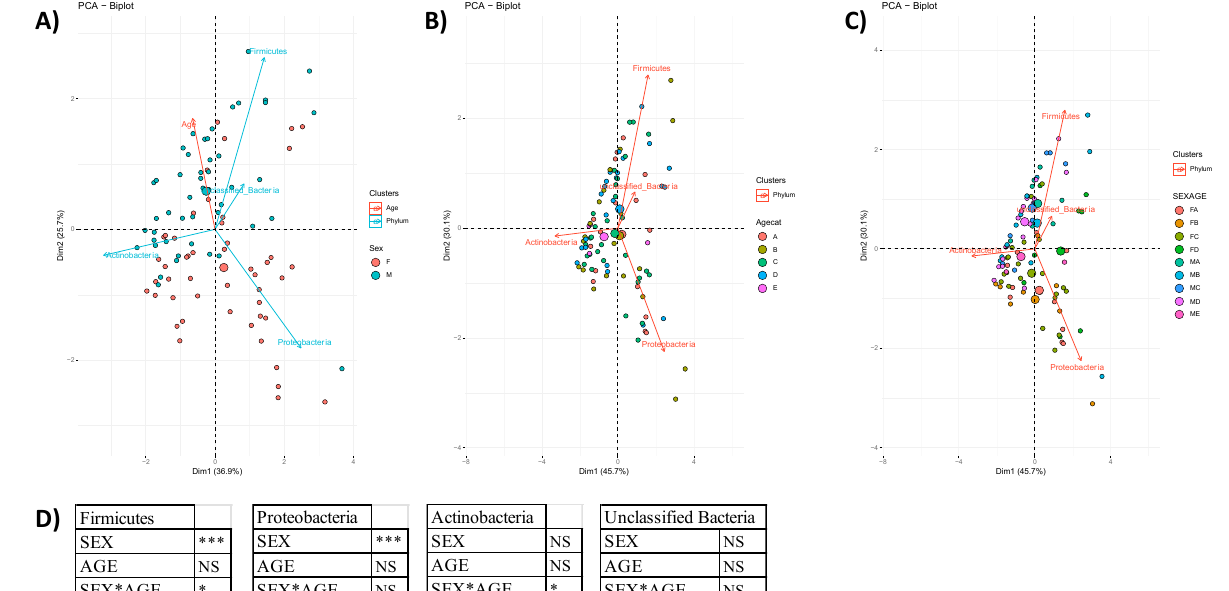
Figure 1. PCA analysis at Phylum level based on the following: ( A ) Sex (62.6% of variability explained by dimensions 1 and 2); ( B ) Age categories (A: 25–35 years old, B: 36–45, C: 46–55, D: 56–65, E: 66–70; 75.8% of variability explained by dimensions 1 and 2); ( C ) Sex + Age categories, 75.8% of variability explained by dimensions 1 and 2). The largest ball represents the mean of the samples, while the small dot indicates the single sample. ( D ) Two-way ANOVA results for the phyla Firmicutes, Proteobacteria, Actinobacteria and Unclassified bacteria considering the two factors “Sex”, “Age” and their interaction “Sex*Age”. NS = Not Significant; * = Significant at p < 0.05; ** = Significant at p < 0.01; *** = Significant at p < 0.001.